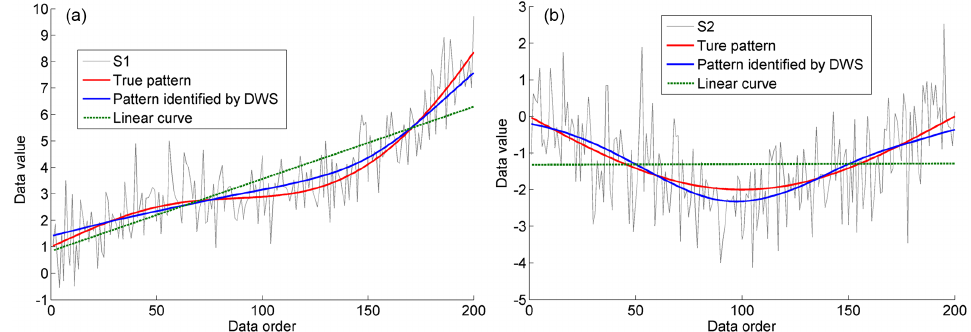
Figure 2. Non-monotonic trends in the synthetic series S1 (a) and S2 (b) identified by the discrete wavelet spectrum (DWS) approach, and the linear trends in the two series. Synthetic series S1 is generated as S 1 = 1 . 112 0 . 1 t + 0 . 8 × sin ( 0 . 01 πt) + α and synthetic series S2 is